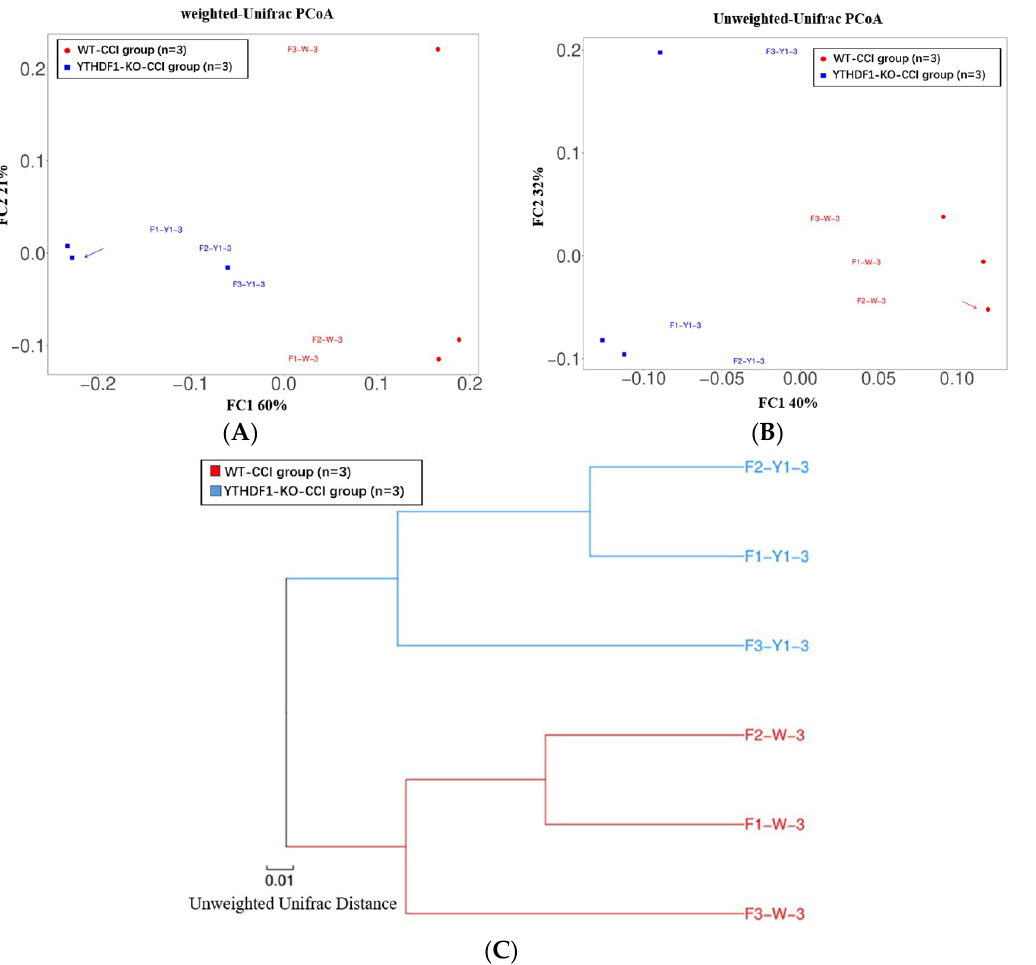
Figure 7. The beta diversity of mycobiome between samples was illustrated by principle coordinate analysis (PCoA) plots of ( A ) weighted and ( B ) unweighted UniFrac distance, showing significant differences of the mycobiome profile between YTHDF1-knockout and WT groups (tested by Per- manova analysis with p < 0.05). ( C ) Clustering dendrogram of mice faecal bacteria using UPGMA (unweighted pair-group method with arithmetic